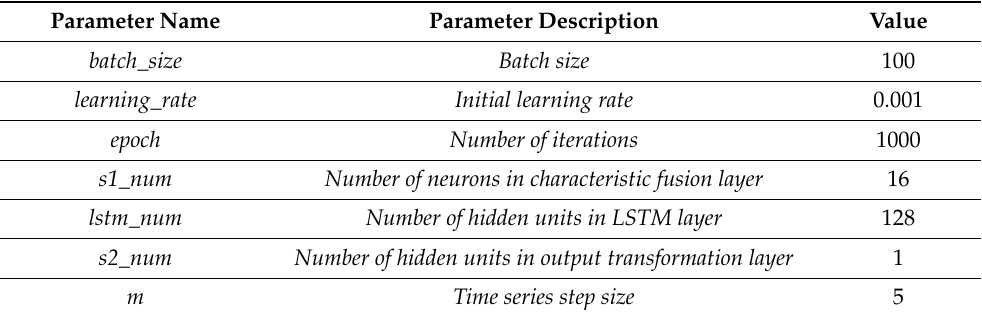
Table 1. Important hyperparameter